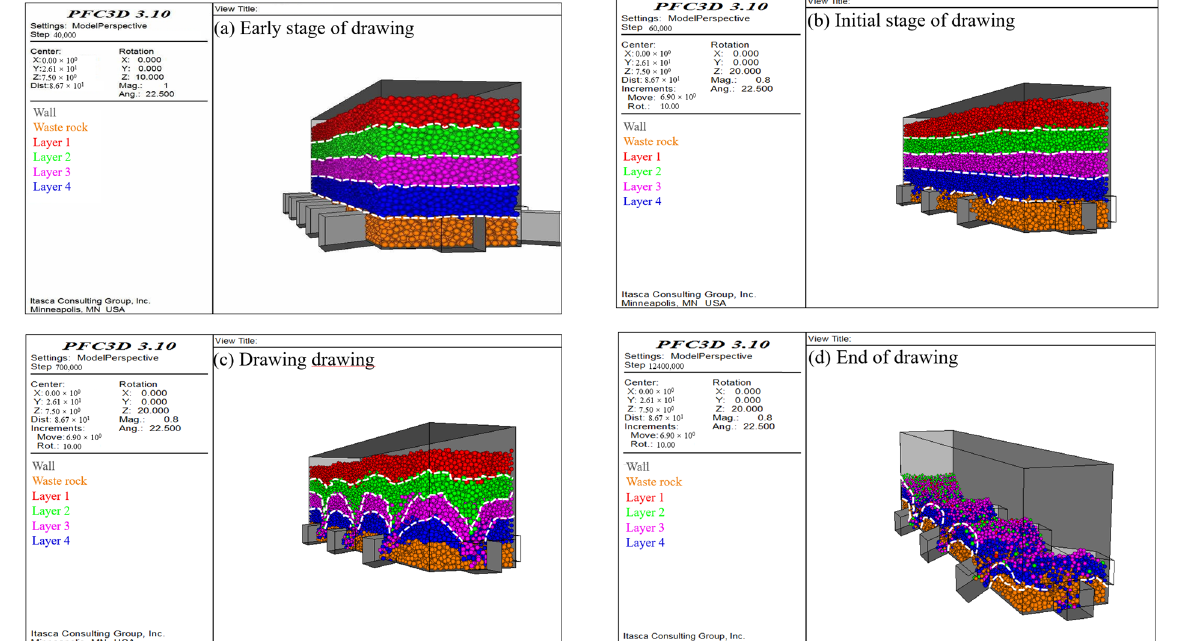
Figure 14. Schematic diagram of the drawing process. ( a ) Early stage of drawing ( b ) Initial stage of drawing ( c ) Drawing drawing ( d ) End of drawing.